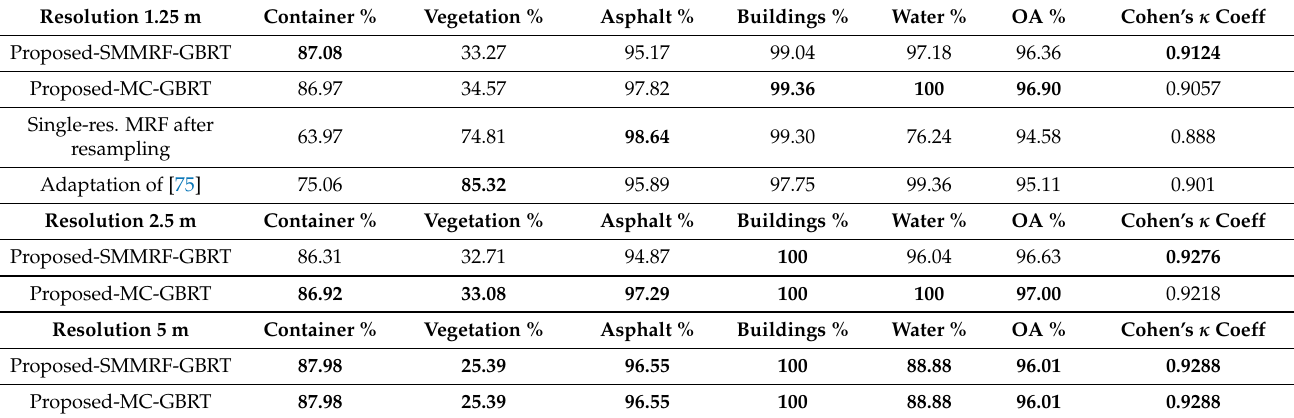
Table 2. “Haiti” dataset: class-wise accuracies of the proposed algorithms, combined with GBRT and compared with benchmark methods, with respect to the test set.